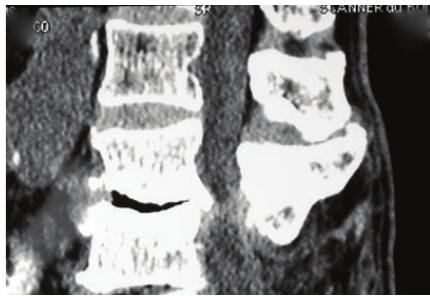
Figure 3: CT scan showing a destruction of L2 vertebral body and L2-L3 disc space. The spinal canal was compromised with paravertebral hypertrophic ossifications (Case 1).